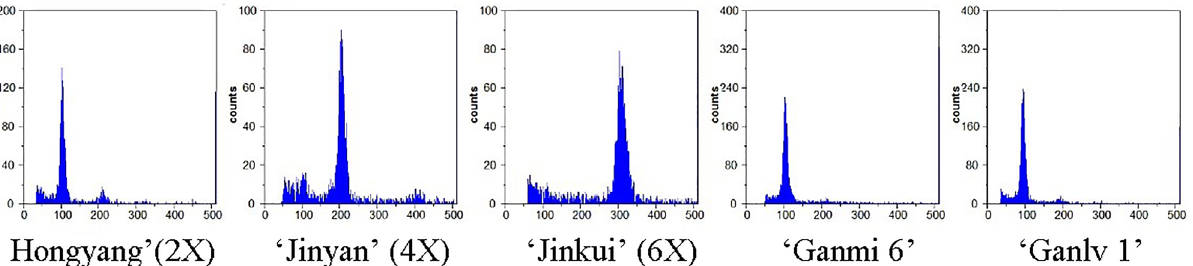
Figure 3. The date of ploidy test. With the known multiplier cv. ‘Hongyang’ (2 ×), cv. ‘Jinyan’ (4 ×), cv. ‘Jinkui’ (6 ×) as the standard sample, set the voltage and flow rate before test the ploidy of